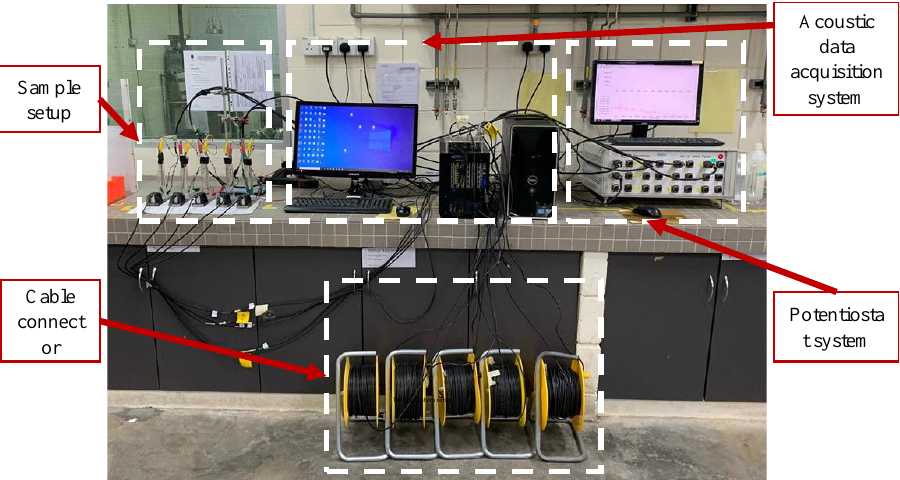
Figure 13. The LPR test setup for corrosion detection and monitoring using acoustic emission